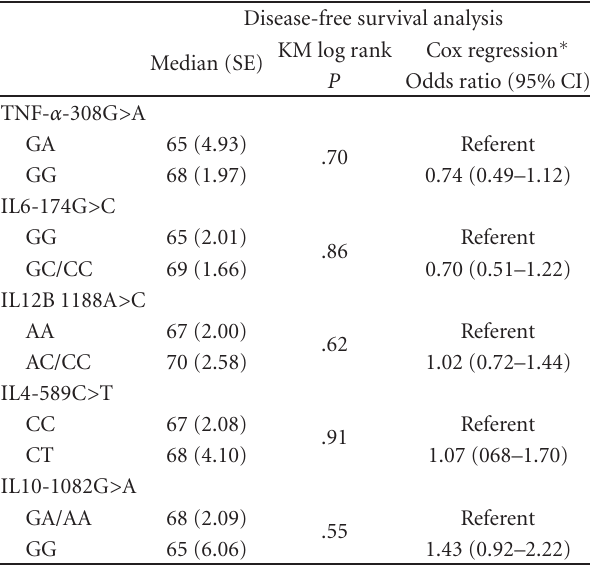
Table 2: Baseline characteristics and genotype frequencies of IS patients.